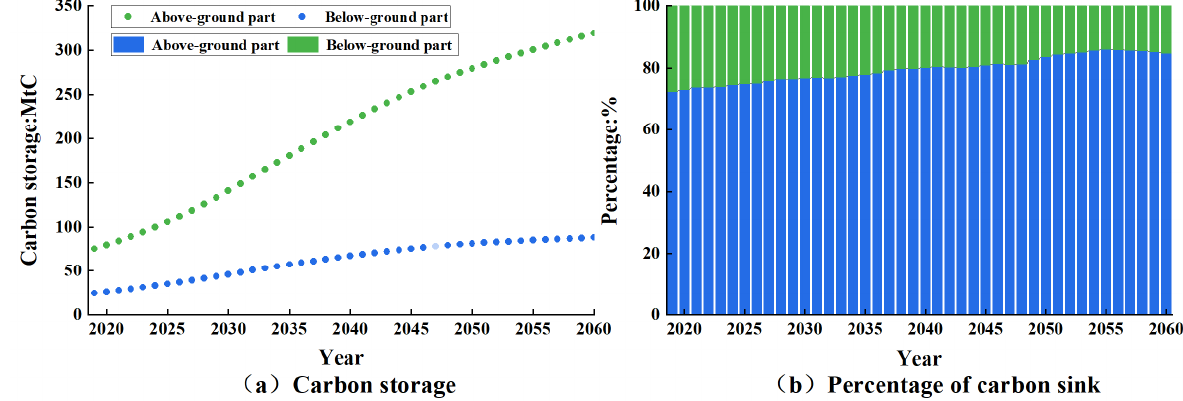
Figure 8. Carbon storage and carbon sinks in above- and below-ground parts of arbor forest vegetation in Henan Province, 2019–2060.